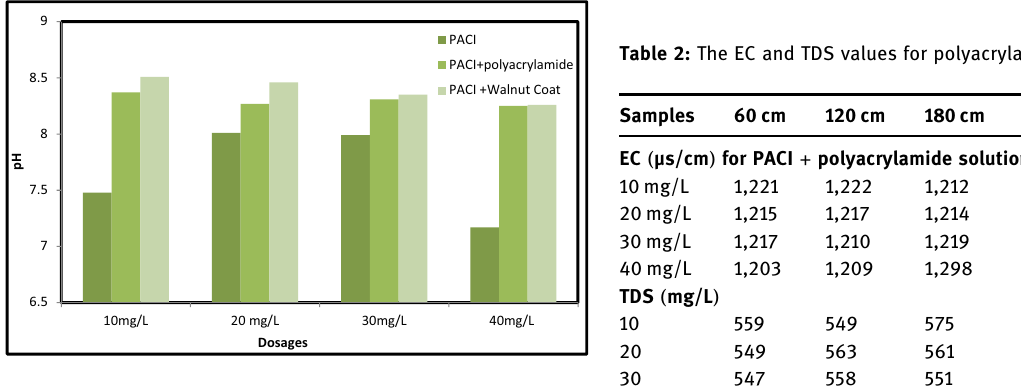
Figure 12: The relation between pH and dosages of coagulant and its aids for samples at 300 cm height.